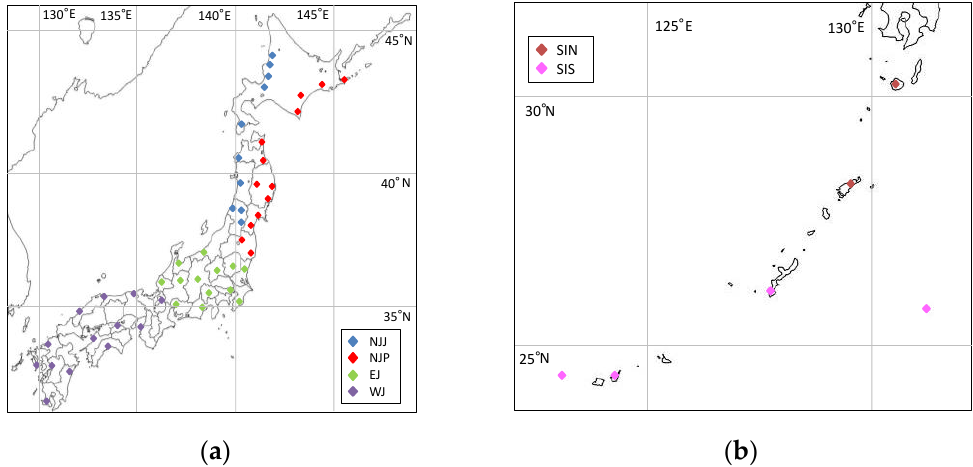
Figure 1. Spatial distribution of meteorological stations for each region of ( a ) the Japanese mainland and ( b ) the Southwestern Islands used for the classification of hot and cool summer years in this study.